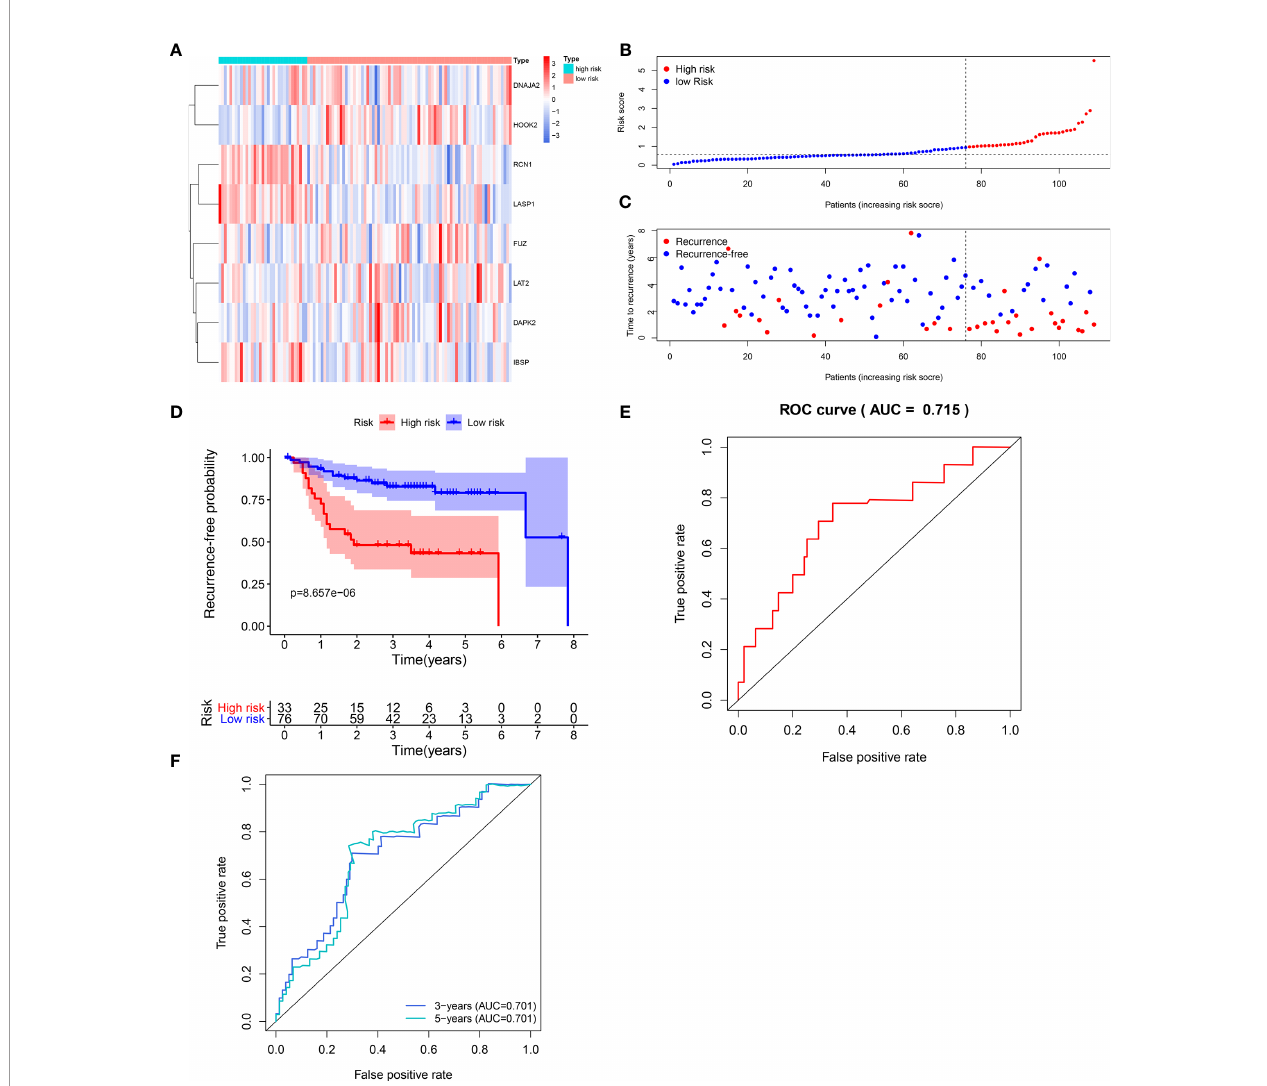
FIGURE 3 | Validation of the predictive ef fi cacy of the signature for predicting recurrence of laryngeal cancer in the veri fi cation set. (A) Heat maps visualizing the differences expression patterns of these eight genes including RCN1, LAT2, DAPK2, DNAJA2, FUZ, LASP1, IBSP and HOOK2 between high- and low- risk score group. Red expresses up-regulation and blue indicates down-regulation. (B) Ranking of risk scores among all laryngeal cancer patients. (C) Distribution of recurrence time among all laryngeal cancer patients. Red dots express recurrence laryngeal cancer samples and blue dots represent non-recurrence samples. The dotted line indicates the optimal cutoff value of risk score. The left side of the line represents low-risk patients, while the right side represents high-risk patients. (D) Recurrence- free survival between high- and low- risk score groups. (E) ROC curve for predicting the patients ’ 1-year recurrence. (F) ROC curves for predicting the patients ’ 3 and 5-year recurrence.